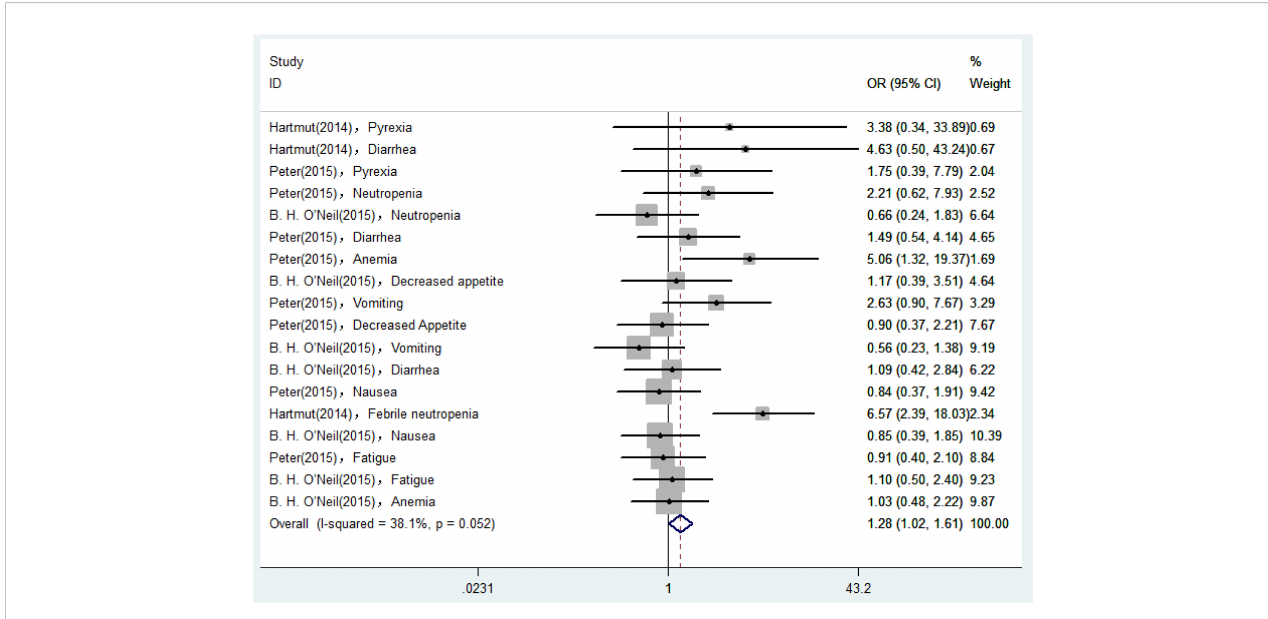
FIGURE 2 Forest plots of the pooled ORs for incidence of AEs in the